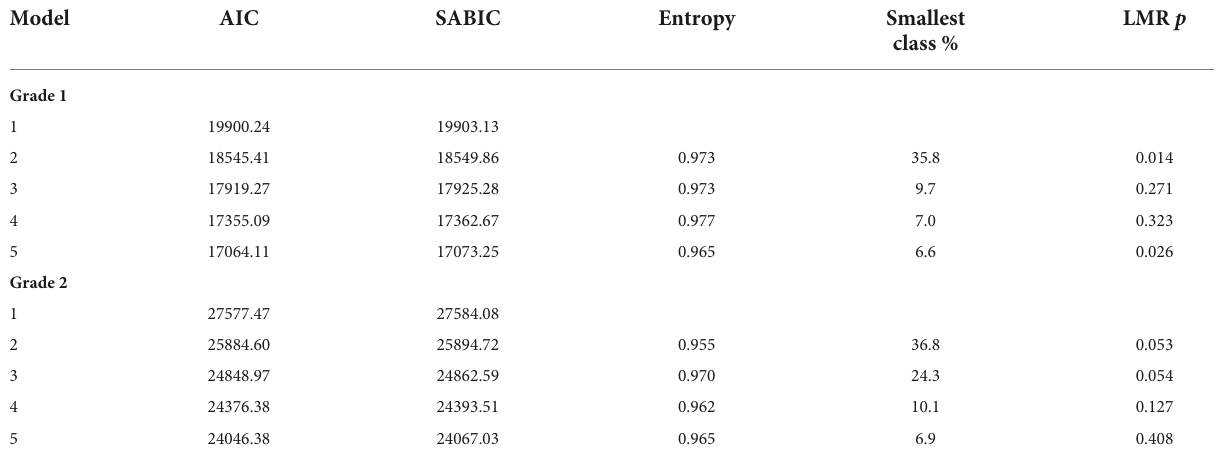
TABLE 7 Goodness-of-fit statistics for LPA models for grade 1 (cohort 1, n = 198) and for grade 2 (cohort 2, n = 216).